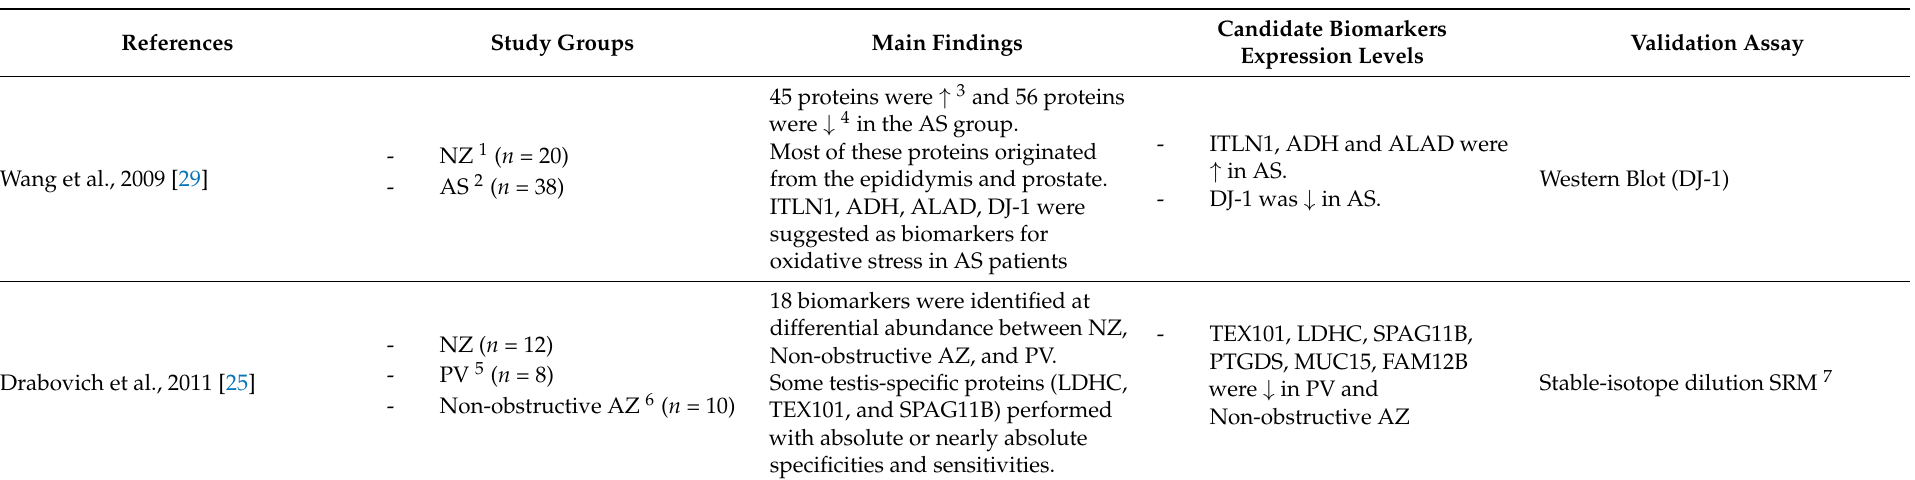
Table 2. MS-based profiling studies on human SP: major proteomics findings and candidate biomarkers of male infertility disorders using bottom-up and top-down